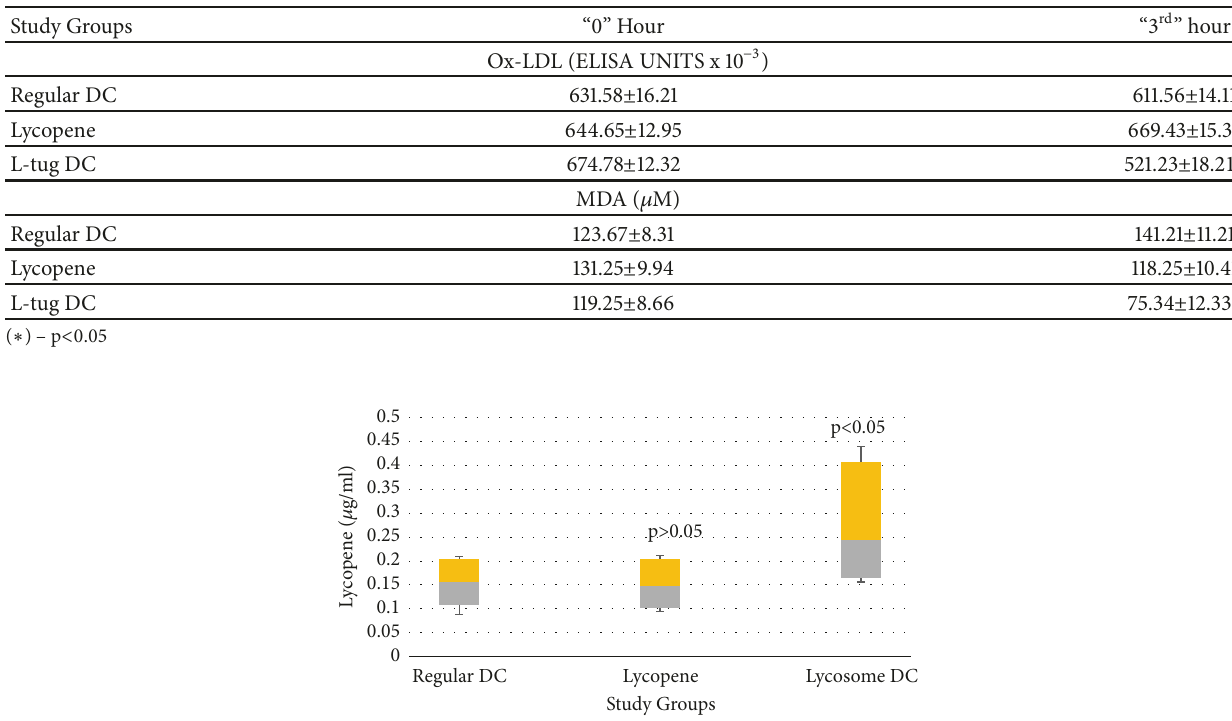
Table 3: Serum oxidized LDL (ox-LDL) and malonic dialdehyde (MDA) levels in volunteers 3 hours after ingestion of dc formulations (averages ± SD).